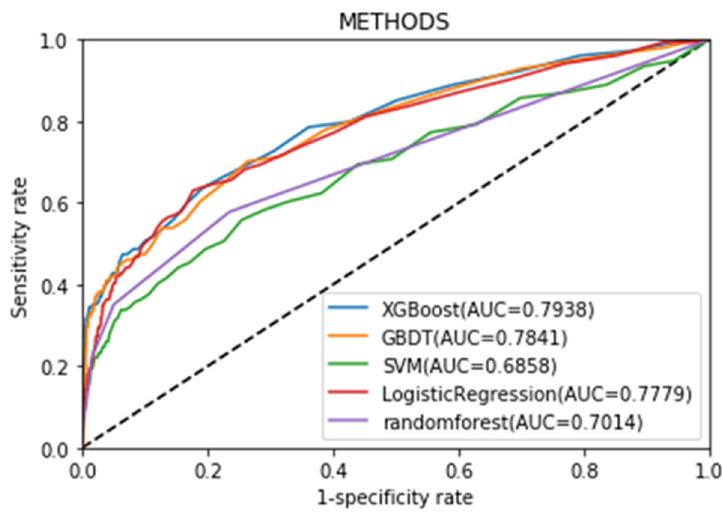
Figure 3. ROC curve of different machine learning prediction models. AUC, area under curve.